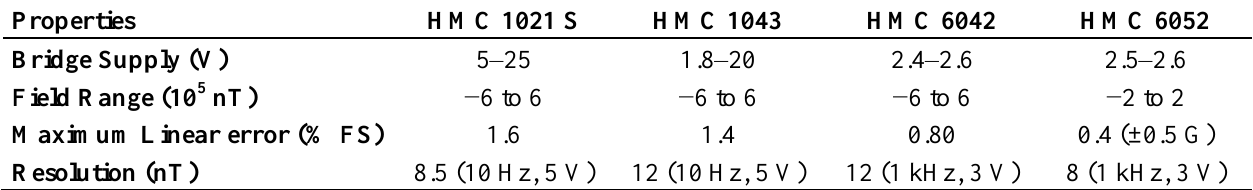
Table 1. Summary of the properties of the different AMR sensors